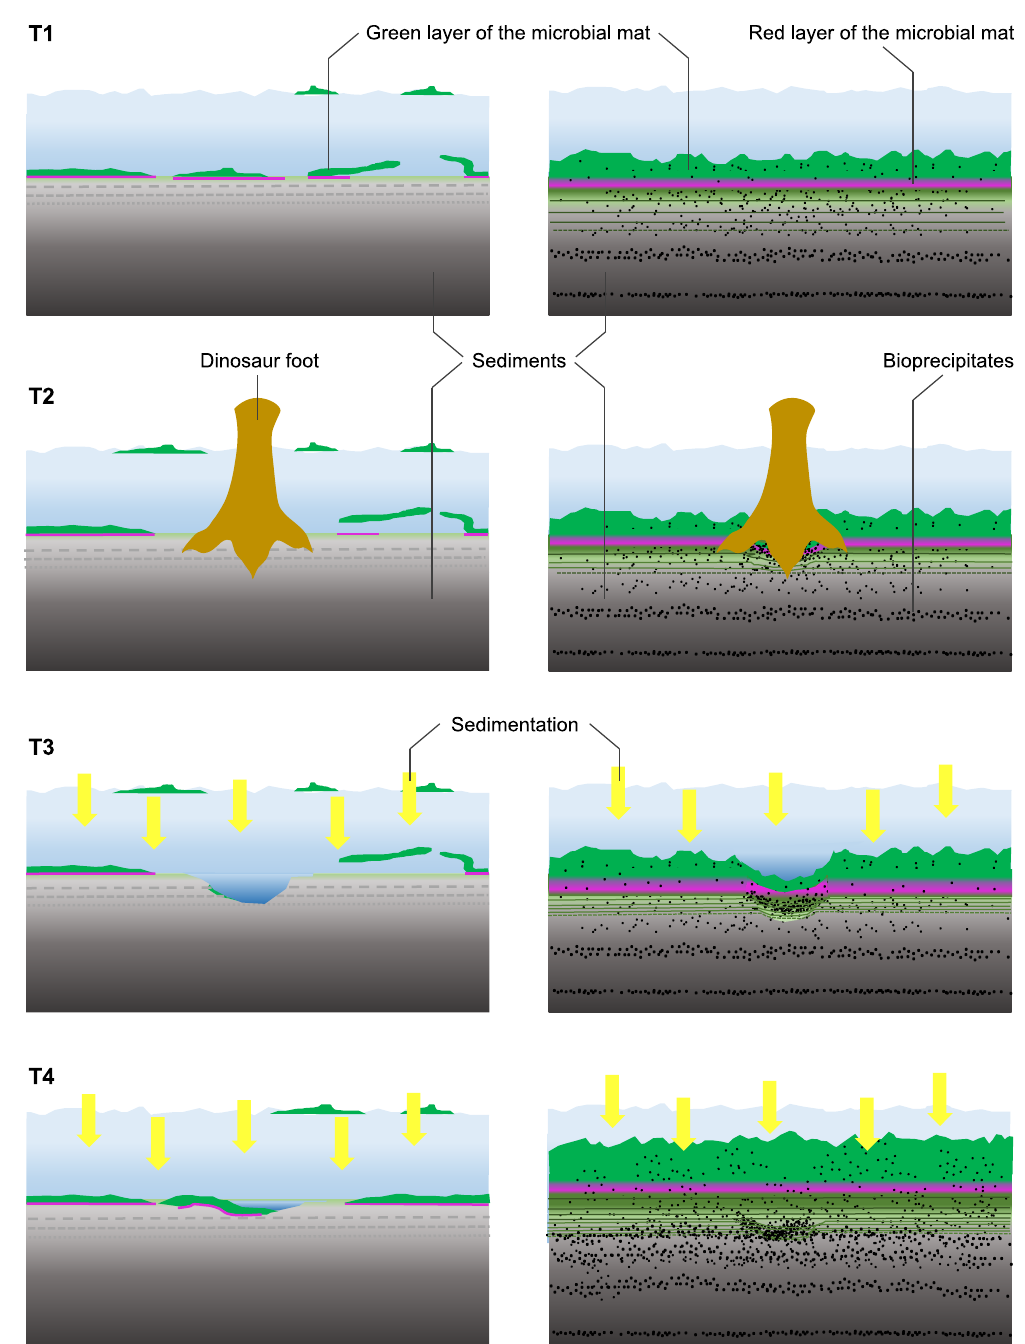
Fig 11. Formation of footprints in microbial mats in a shallow column of water. The left column represents a simple, slim and slightly floating mat. The right column considers a complex and consistent benthic mat. The animal foot tearing the mat, would have printed the bottom substrate. On the left sequence there would not be vertical continuity between the mat and the substrate, and traces would have had imprecise limits. On the right, the foot would deform the surface, and the mat layers would slide towards the inner footprint surface. The compression of the mat would favor the concentration of the inorganic particles crucial to biomineralize and lithify the substrate.